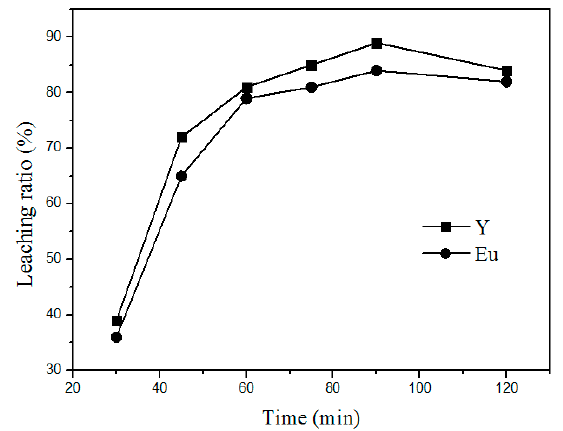
Figure 5. Effect of roasting time on the leaching rate of the rare earths.